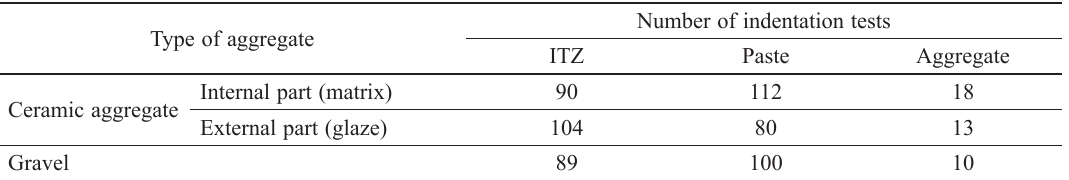
Table 4. Number of indentation test performed in each type of aggregate